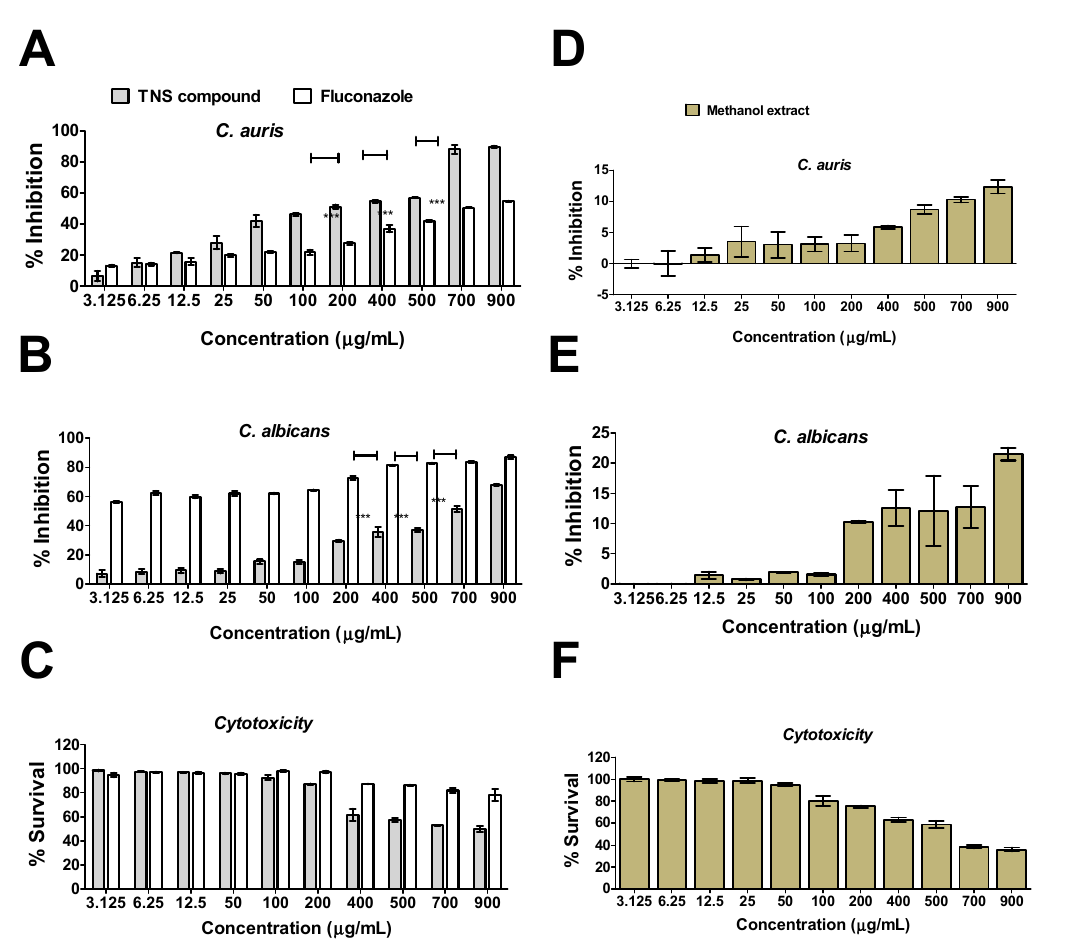
Figure 4. Anti- Candida and cytotoxic activities of the TNS compound vs. plant leaves methanol extract. ( A ) C. auris growth inhibition by compound TNS at different concentrations. ( B ) C. albicans growth inhibition by compound TNS at different concentrations. Candida at 10 4 CFU/mL was grown in 96-well microplates containing YPD broth. The plates were incubated at 37 ◦ C for 24 h prior to measurement at 600 nm using a plate reader. Fluconazole and cultures containing the DMSO vehicle without the compounds were employed as positive and negative controls, respectively. The % inhibition activity of the compounds was calculated relative to the negative control, while the negative control represents 100% growth. ( C ) Cytotoxic activity of TNS against HDF mammalian cells. TNS was tested on HDF cells using an MTT assay. Mammalian cells were seeded in a 96-well plate until confluency, followed by incubation with the samples overnight prior to the MTT assay. ( D , E ) Growth inhibition of C. auris and C. albicans by plant leaf methanol extract at different concentrations. ( F ) Cytotoxic activities of methanol extract on HDF cells using an MTT assay. The data display the mean percentage of the survival rate of mammalian cells ± SEM of five replicates. The data were analyzed using two-way ANOVA and the statistical significance between means was calculated with Bonferroni’s multiple comparisons test. The significance levels are indicated by asterisks. A p -value < 0.05 was considered as significant.